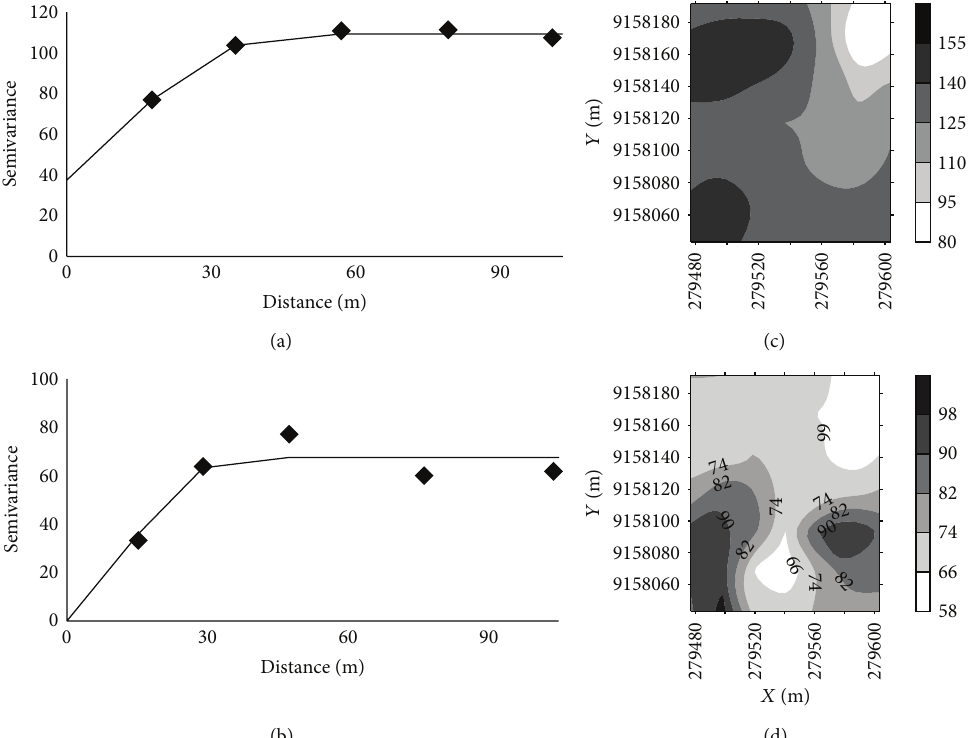
Figure 6: Semivariograms of the parameters of 𝜎𝑝10 % (a) and 𝜎𝑝19 % (b) and contour maps of 𝜎𝑝10 % (c) and 𝜎𝑝19 % (d).